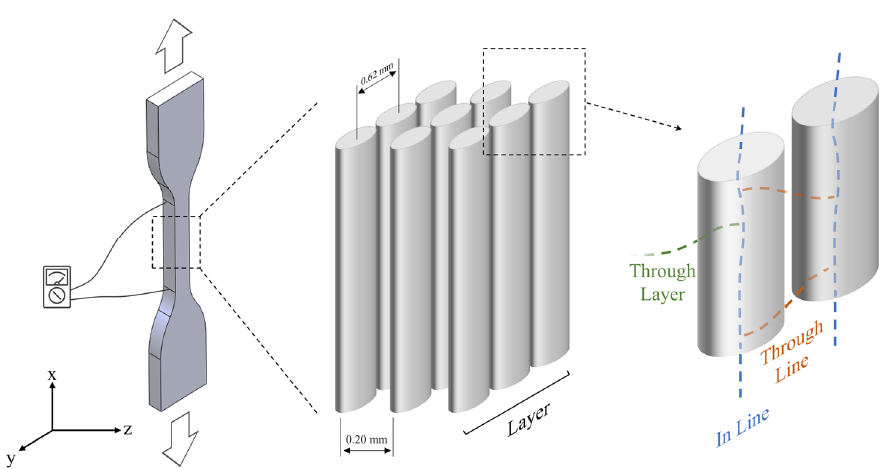
Figure 5. Schematic of the 3D-printed tensile specimens’ morphology and electrical conduction pathways.